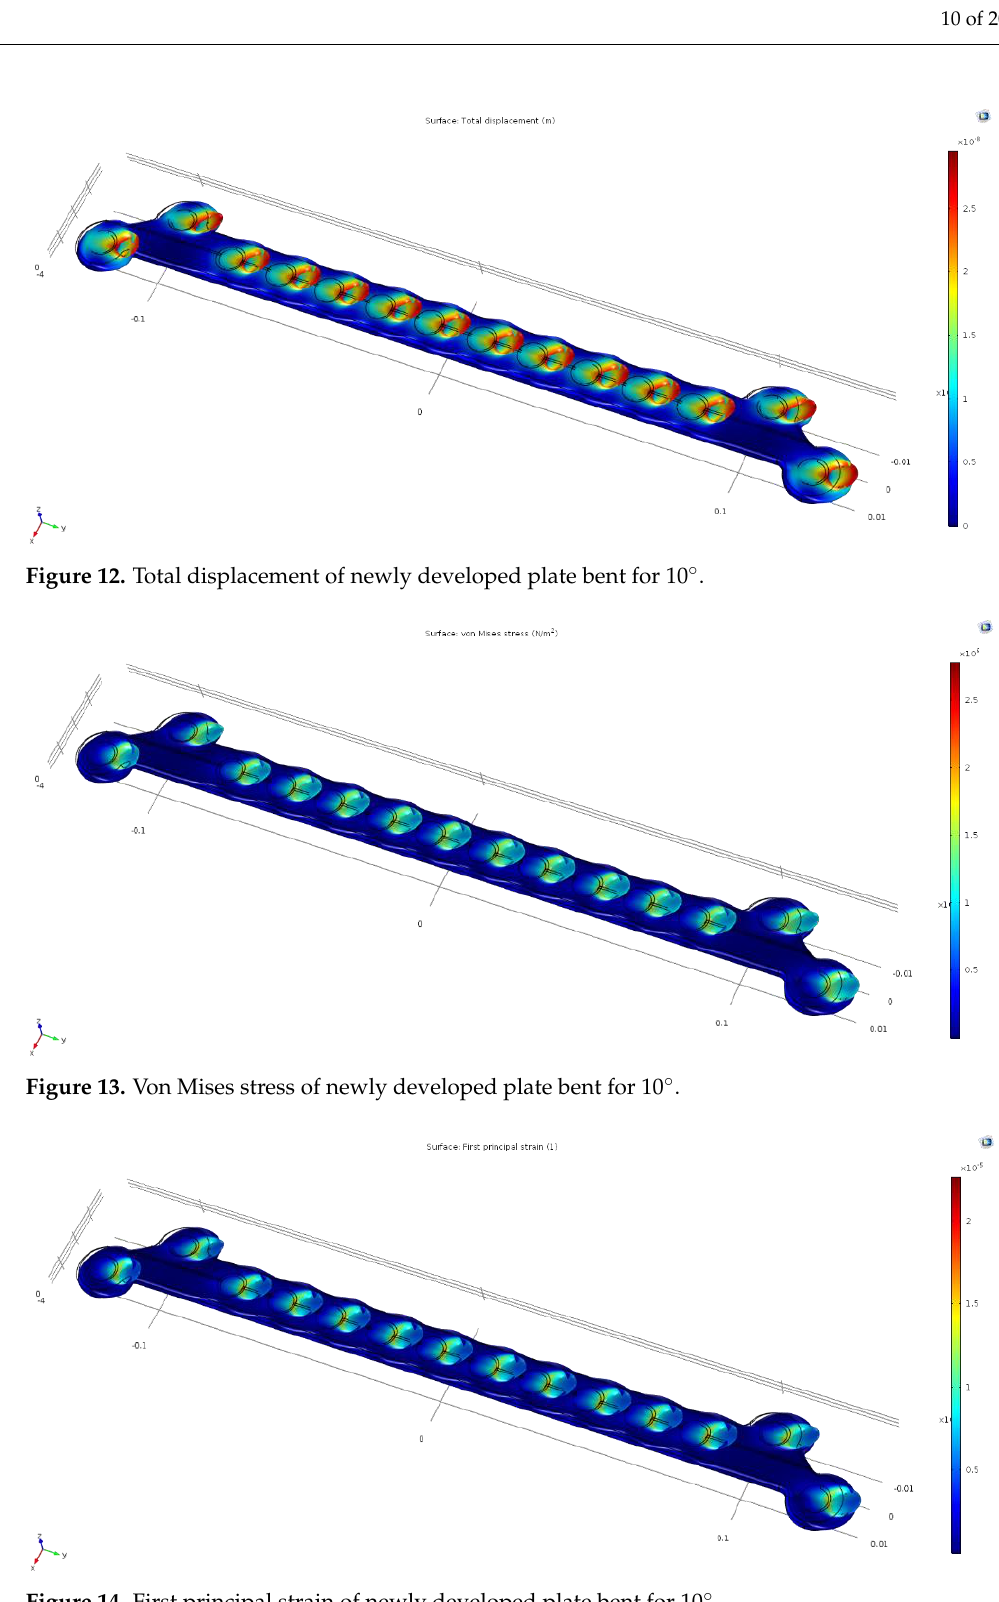
Figure 14. First principal strain of newly developed plate bent for 10°.